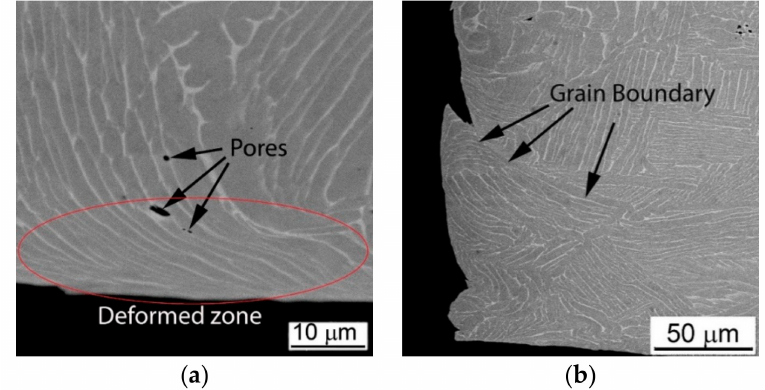
Figure 17. Microstructure of the non-cracked Ti64BEPM specimen tested at the strain rate of 2100 s − 1 : ( a ) plastic deformation in zone I; ( b ) shear deformation in the vicinity zone I. SEM,